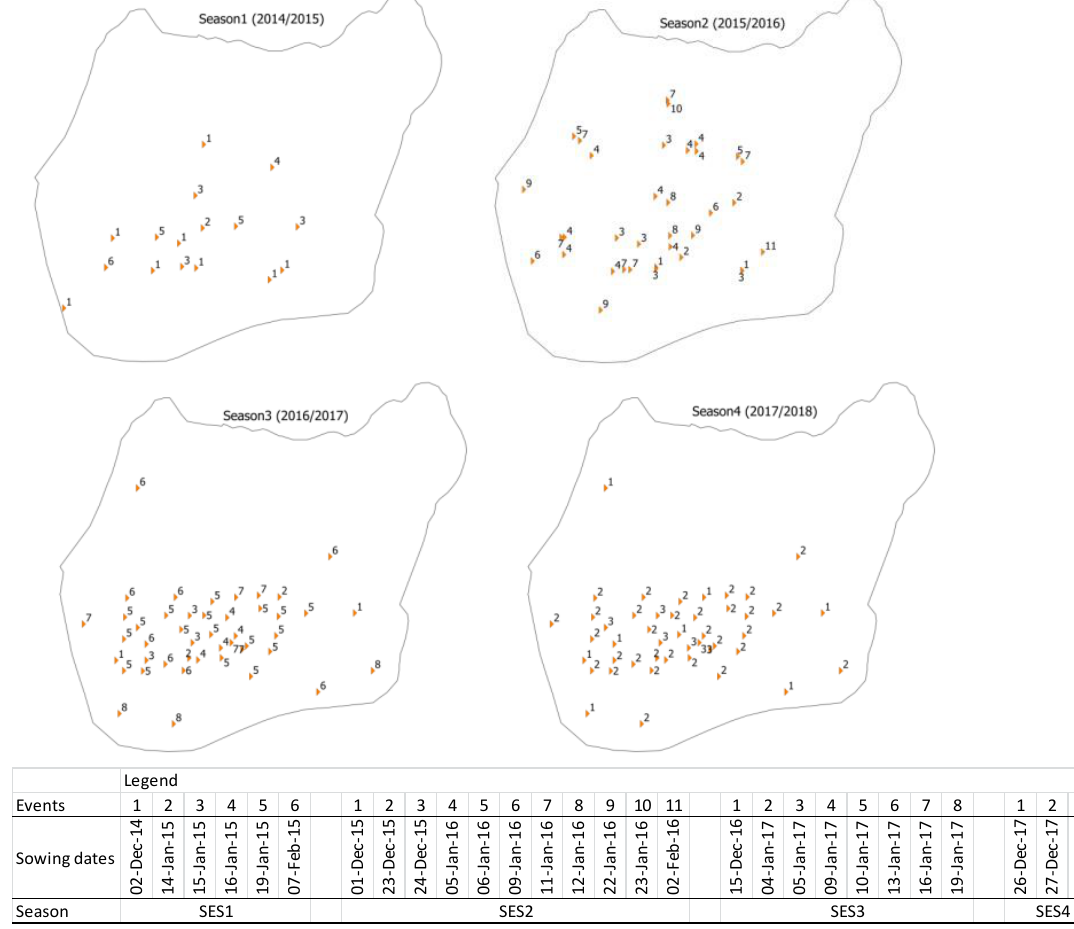
Figure 3. The spatial distributions of farmers’ planting events over the four seasons (the numbers in the map denote planting events for each season as presented in the legend).